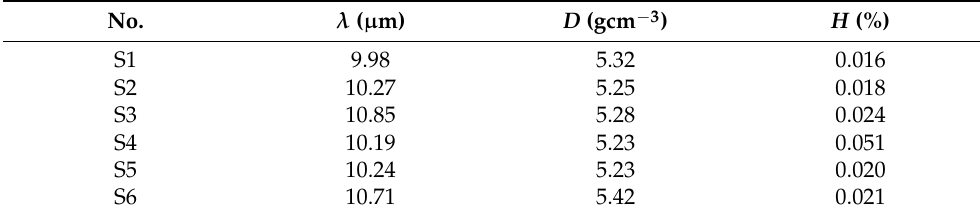
Table 1. Average grain sizes ( λ ), densities ( D ), and porosities ( P ) of Co 2 O 3 -doped ZnO varistors. No. λ ( µ m) D (gcm − 3